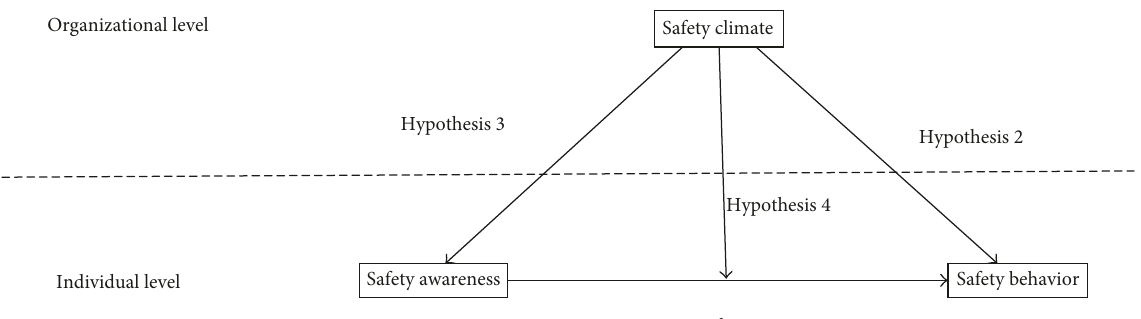
Figure 2: Research model and hypotheses.